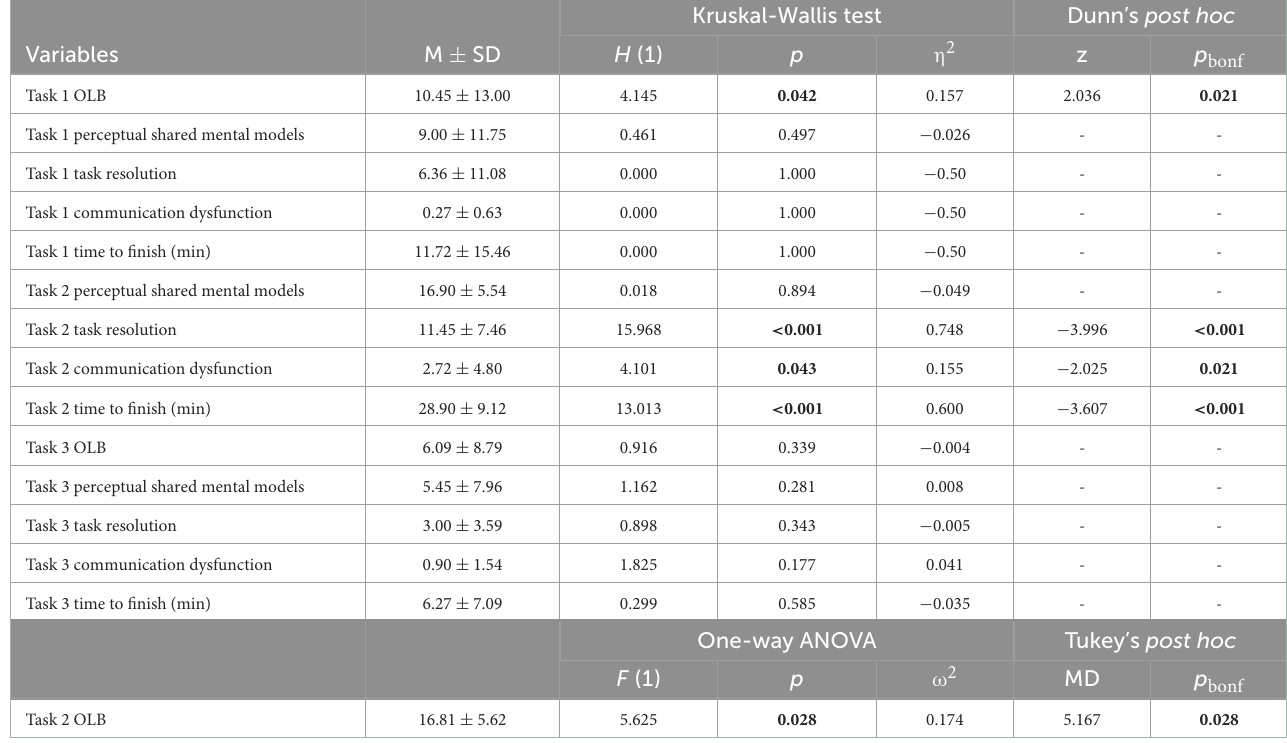
TABLE 4 Comparison of observational scores between VDE and Arkime ( N = 22).